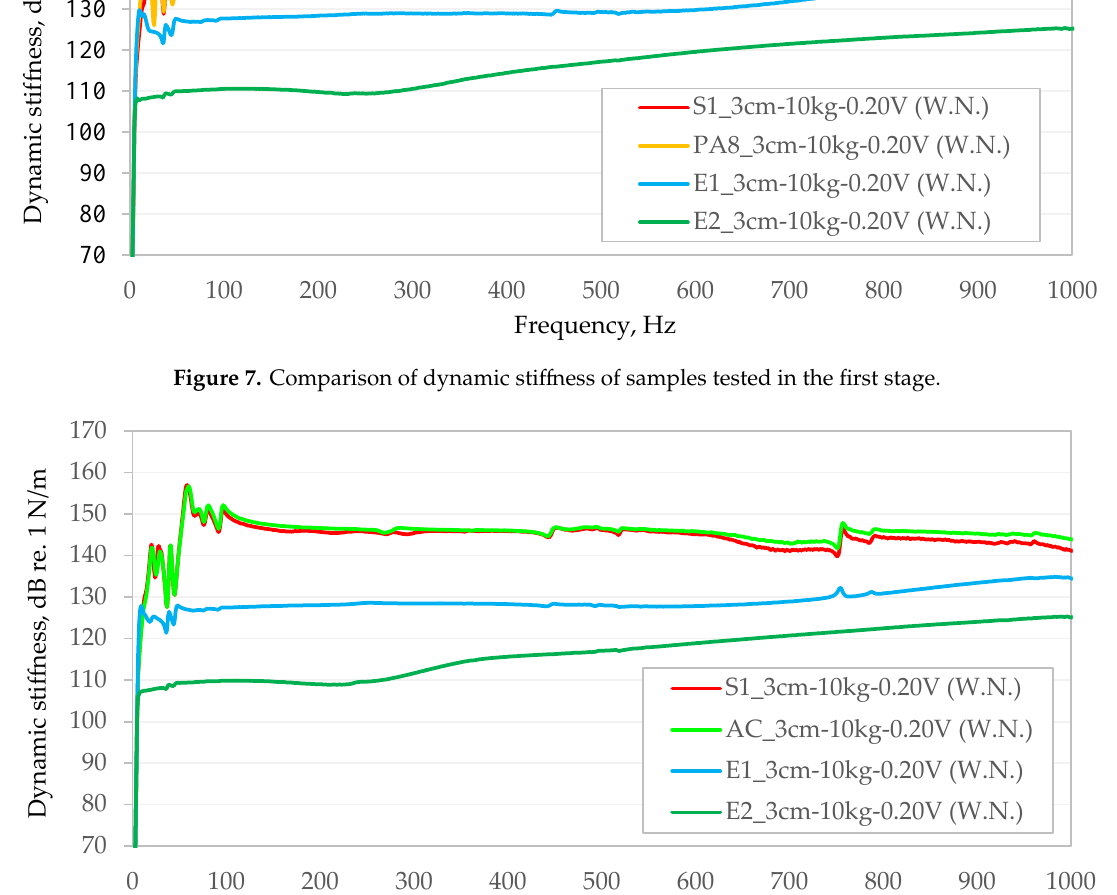
Figure 8. Comparison of dynamic stiffness of samples tested in the second stage.